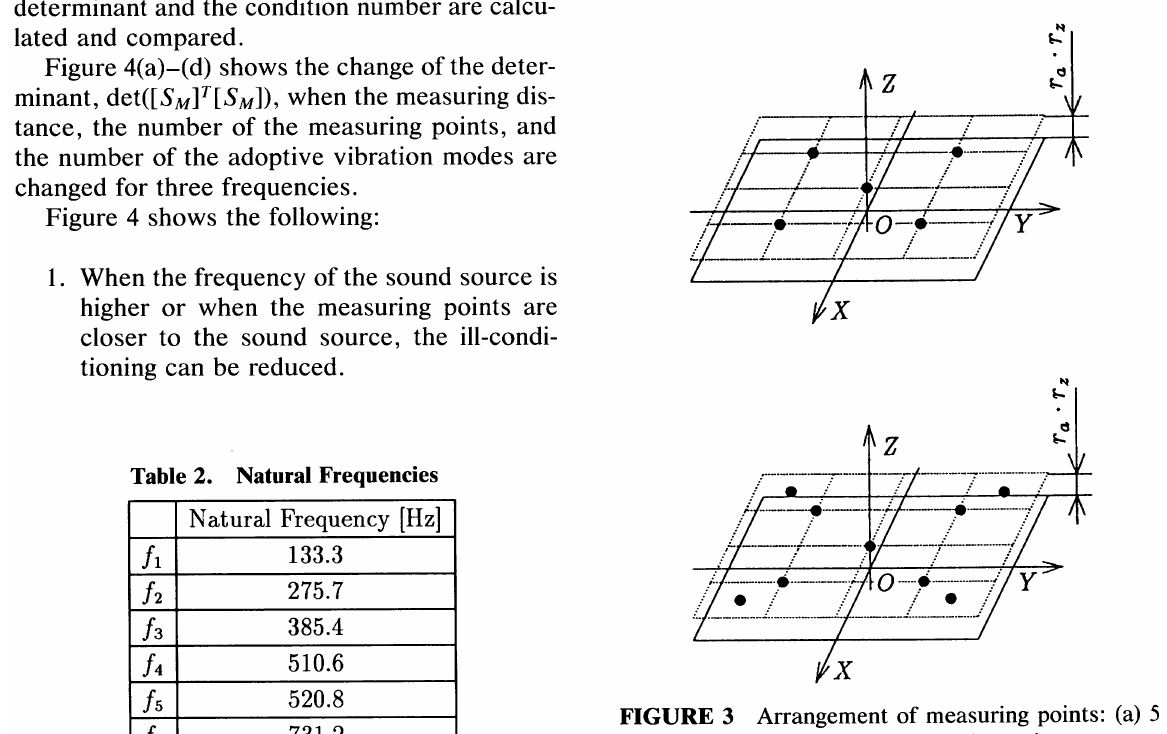
FIGURE 3 Arrangement of measuring points: (a) 5 measuring points and (b) 9 measuring